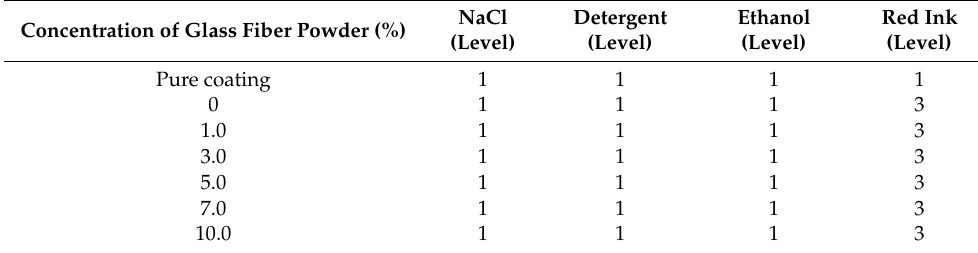
Table 8. Effect of glass fiber powder concentration on the level of waterborne coatings with thermochromic ink for liquid resistance.